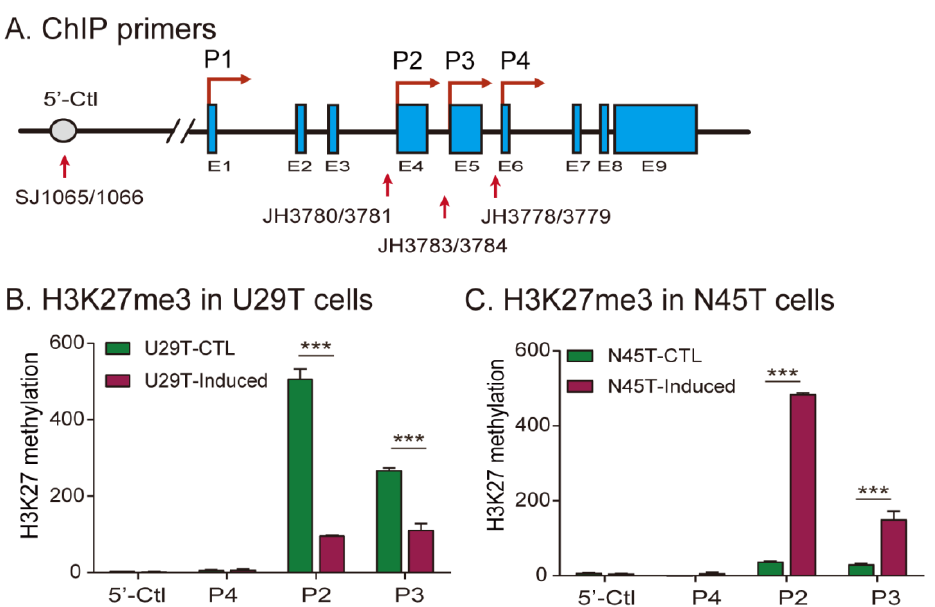
Figure 4. H3K27 methylation in the promoter of IGF2 . ( A ) Location of PCR primers used for H3K27 methylation. Two primer sets JH3780/JH3781 and JH3783/JH3784 are used to quantitate H3K27 methylation in promoters 2 and 3 of IGF2 . The primer set (SJ1065/SJ1066) for the P1 promoter upstream site ( 5′ -Ctl) is used as the negative control. ( B , C ) Histone methylation in the IGF2 promoter of U29T cells ( B ) and N45T ( C ) cell lines. U29T cells exhibited IGF2 LOI after decidualization, while N45T cells maintained normal imprinting. Histone modifications in the IGF2 promoter were measured by ChIP assay using antibodies specific for H3K27me3. Normal rabbit IgG was used as a negative control and was used for normalization. The data are the mean ± SD from three independent experiments. *** p < 0.001as compared with control cells (CTL). Note the reduced H3K27me3 level in decidualized N29T cells that demonstrate IGF2 LOI.